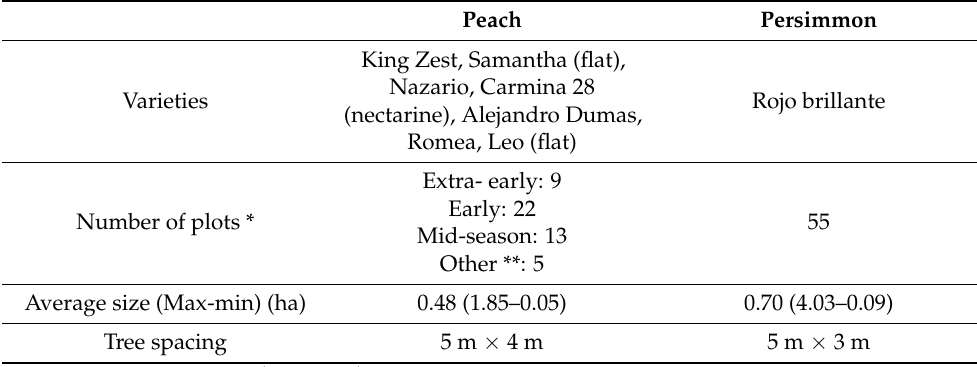
Rojo brillante 55